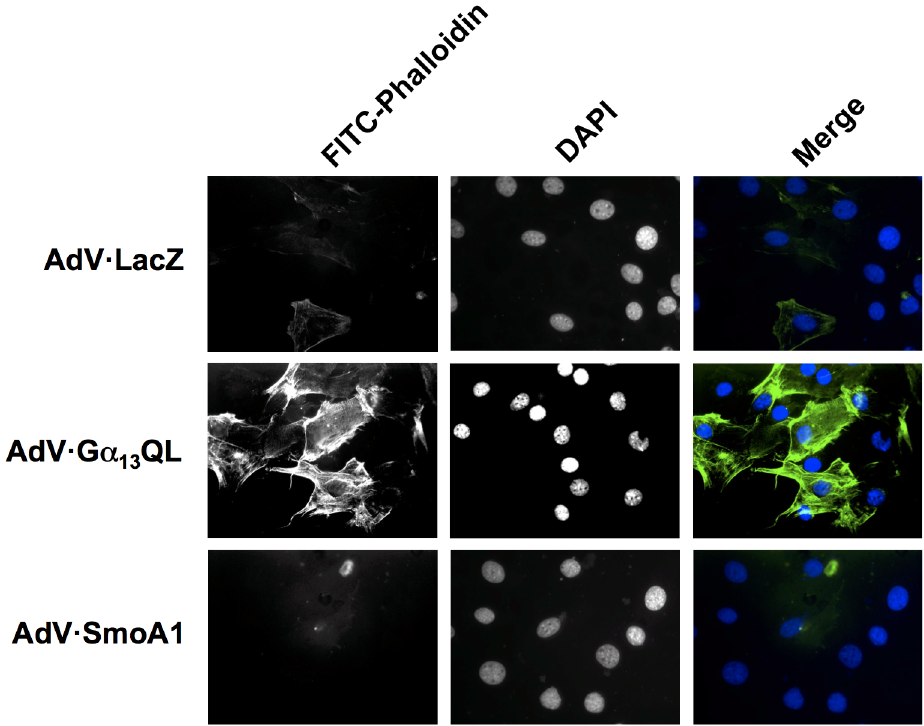
Fig 3. Stress fiber formation in response to SmoA1 and G α 13 QL. C3H10T1/2 cells grown on coverslips were serum- starved for 12 h then incubated with recombinant adenoviruses encoding LacZ, SmoA1, or G α 13 QL (MOI = 10) in the presence of DEAE-Dextran (10 μ g/ml). They were serum-starved an additional 18 h and fixed with paraformaldehyde. F-actin was stained with FITC-Phalloidin, and nuclei were counterstained with DAPI. ‘Merge’ is pseudocolored. Shown is one experiment representative of three total. Few or no stress fibers were identified in the absence of transduction (S2 Fig).